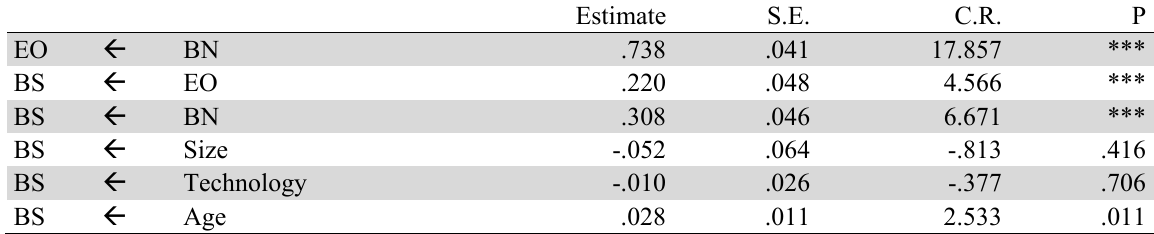
The Regression Path Coefficients and its significance based on p-value < 0.05 with control included